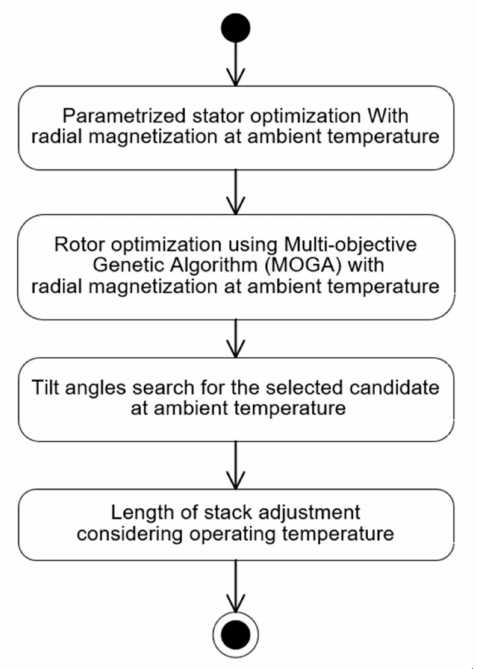
Figure 12. Optimization